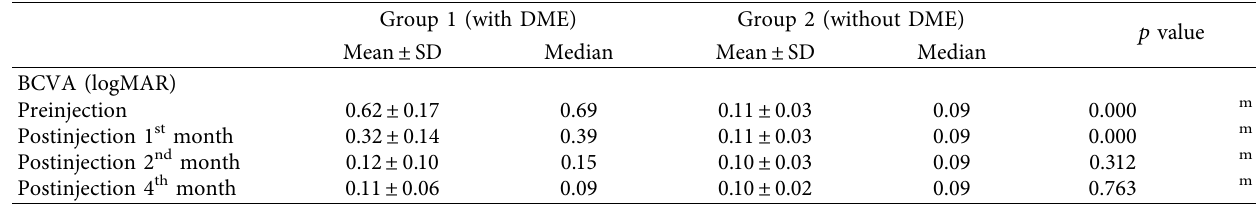
Table 2: Change in best corrected visual acuity of the groups.